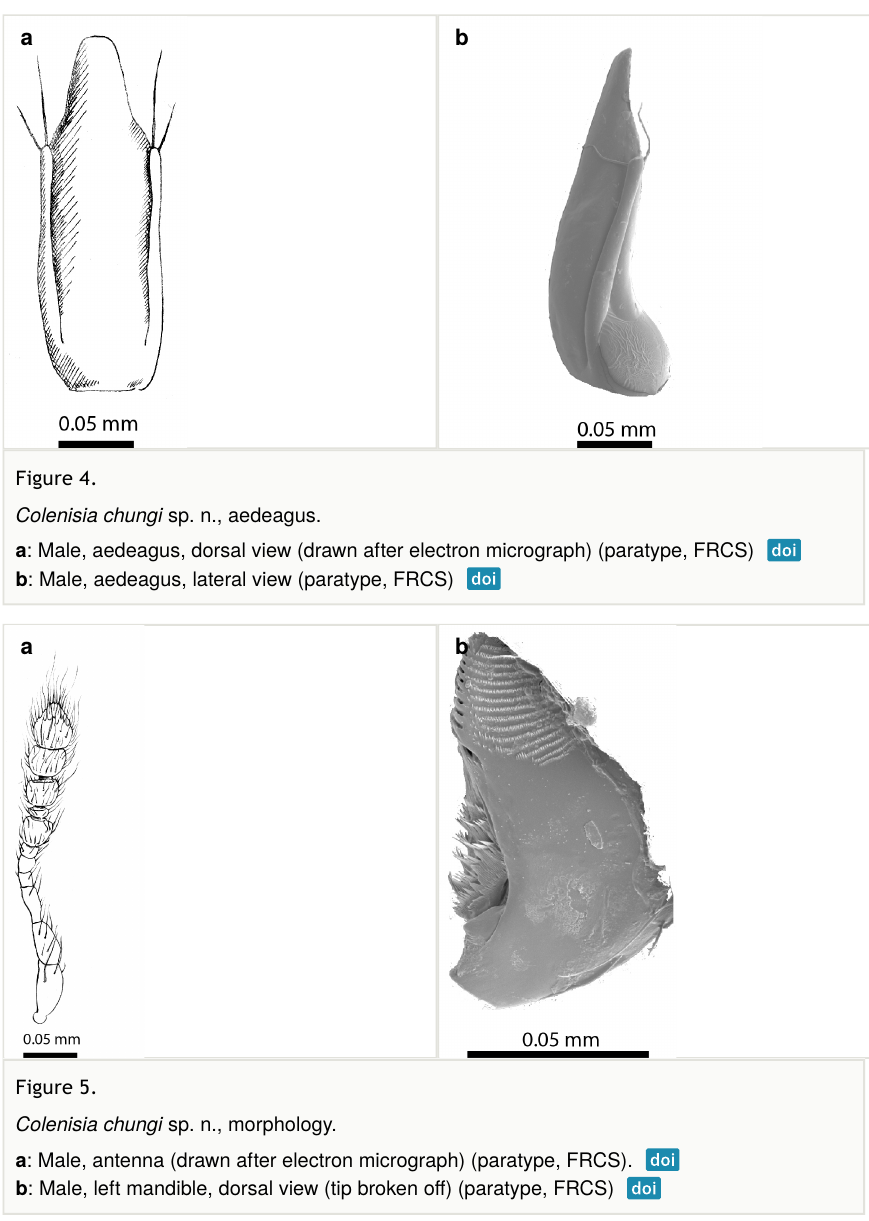
Figure 5. Colenisia chungi sp. n., morphology. a : Male, antenna (drawn after electron micrograph) (paratype, FRCS). b : Male, left mandible, dorsal view (tip broken o ff ) (paratype,